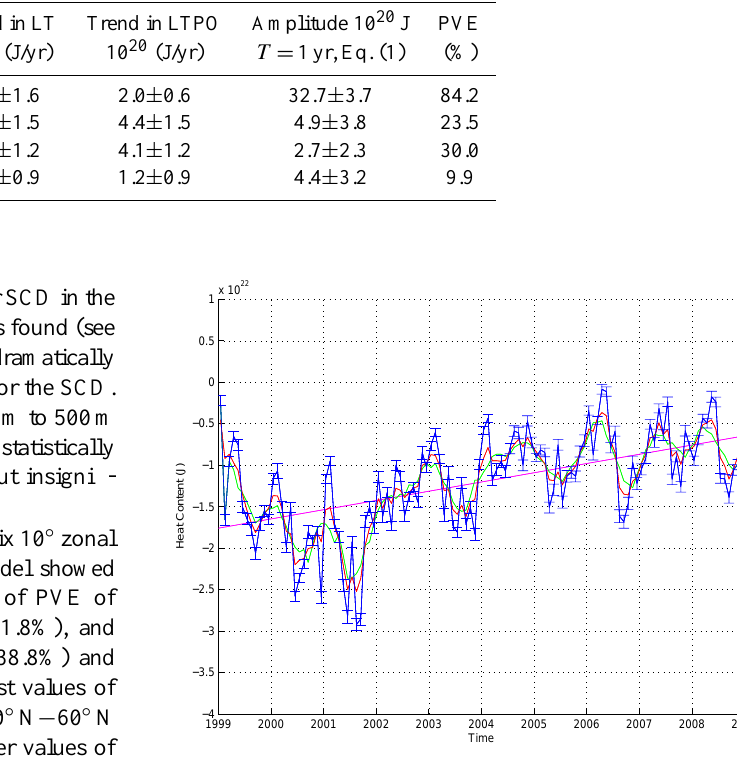
Fig. 8. HCD for the layer between 0 and 2000m. The vertical bars represent one standard deviation. Blue is HCD, green is a moving averaged HCD and red is the HCD filtered with a 7 point low pass filter. The magenta represents a linear